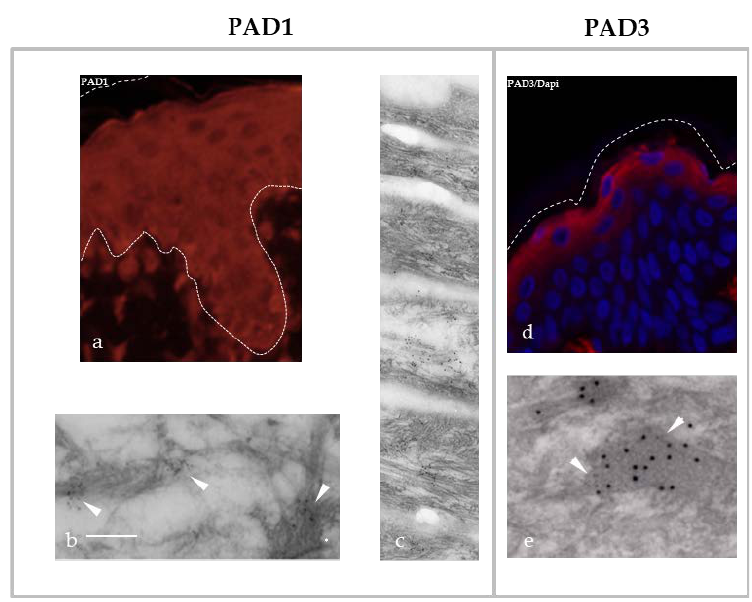
Figure 2. Localization of PAD1 ( a – c ) and PAD3 ( d – e ) in human epidermis. ( a , d ) Immunofluorescence and ( b , c , e ) immuno-electronic microscopy detection on normal human skin. Bar, 200 nm. The white dashed lines indicate either the dermo-epidermal junction ( a ) or the top of the Stratum corneum ( a , d ). White arrowheads point to the immunogold labeling of PAD1 on keratin IF ( b ) and PAD3 on keratohyalin granules ( e ).